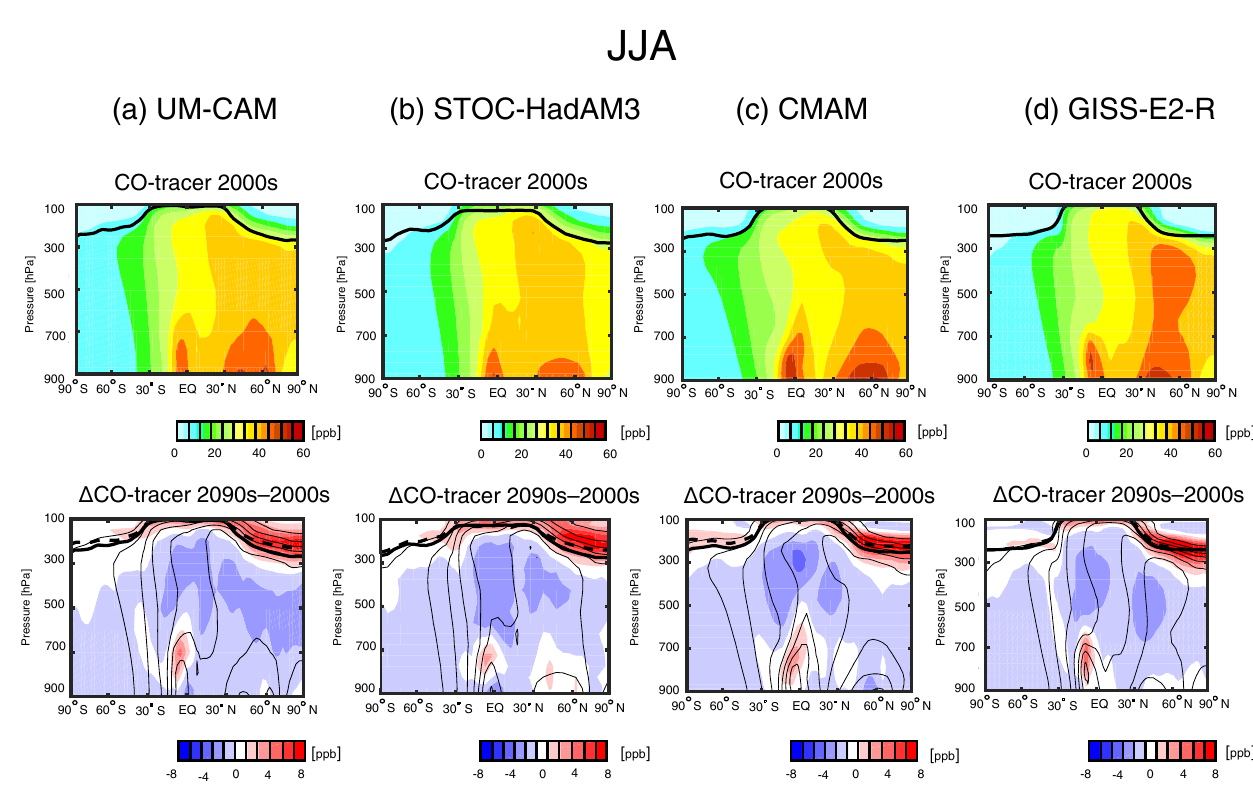
Figure 3. Same as Fig. 2 but for boreal summer